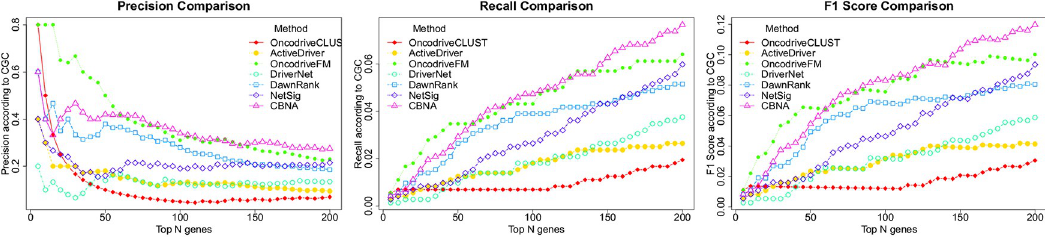
Fig 6. Comparison of Precision, Recall, and F 1 Score for the top ranking genes predicted by OncodriveCLUST, ActiveDriver, OncodriveFM, DriverNet, DawnRank, NetSig, and CBNA. In each diagram, the x-axis is the number of the top ranking genes. The y-axis is the value of Precision , Recall , or F 1 Score